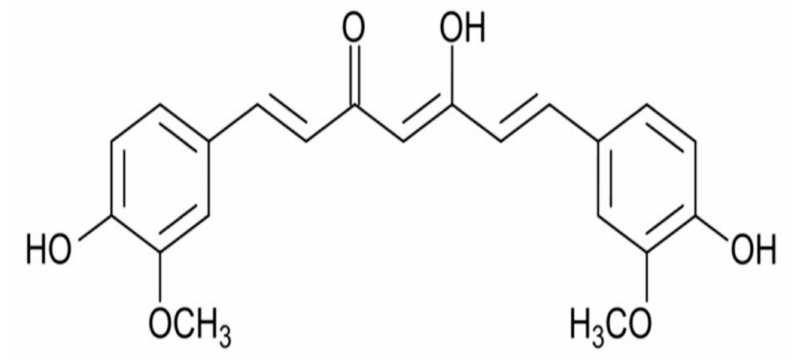
Figure 1. Structure of